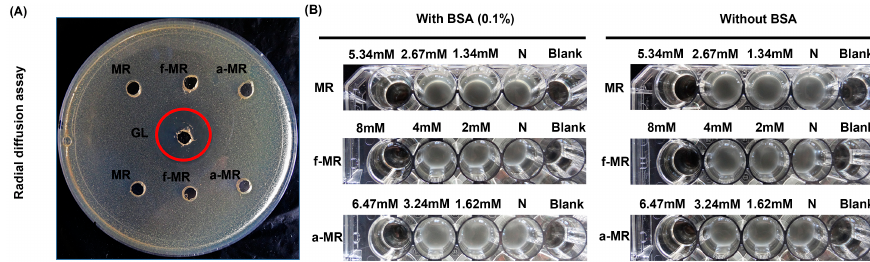
is shown. All of MR, f-MR, and a-MR was at 10 mM, while GL was at 2.1 mM; and ( B ) the antibacterial activity of peptides with 0.1% BSA in the LTM is shown. The symbol “N” represents the negative control group without peptides. Results are typical results of three separate